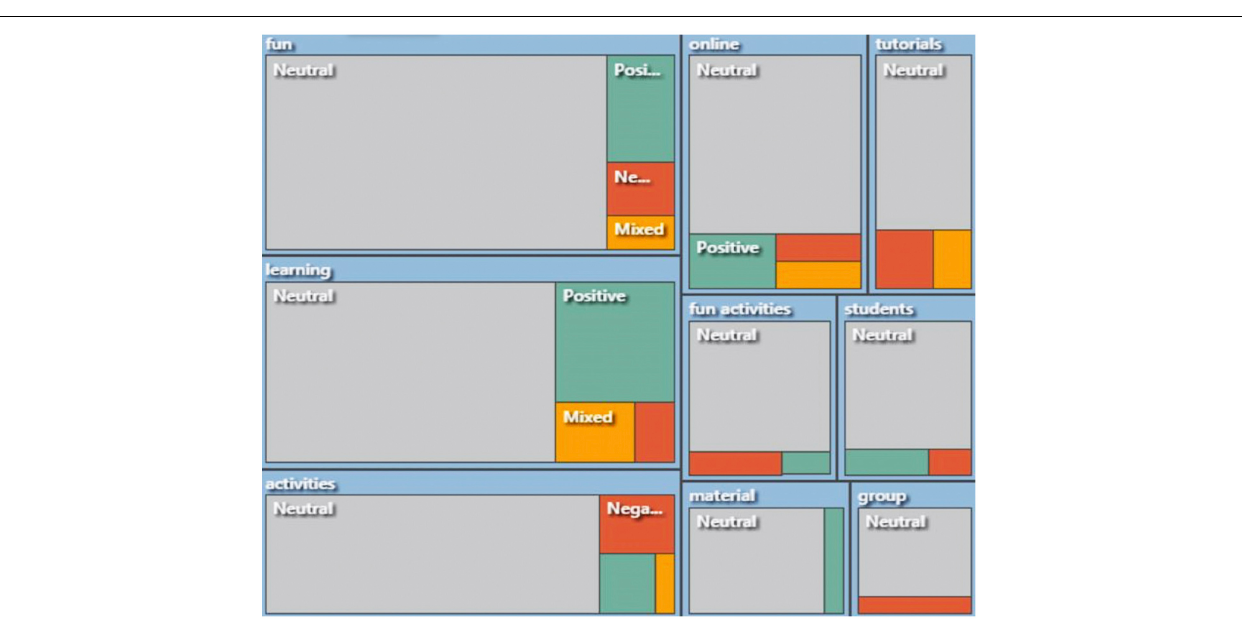
FIGURE 4 | RRI sentiment analysis about Online Learning and Fun in NVivo